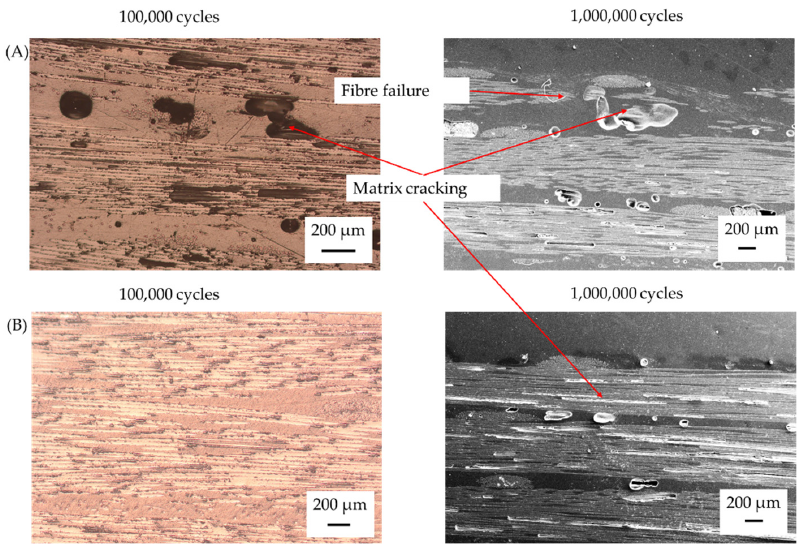
Figure 10. Optical analysis of GFRP after at 50% maximum flexural loading for ( A ) GF for 100,000 cycles and after 1 million cycles ( B ) GFT for 100,000 cycles and after 1 million cycles